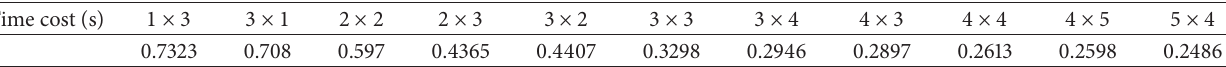
Table 3: Time cost of 124 ∗ 124 image with different neighborhood